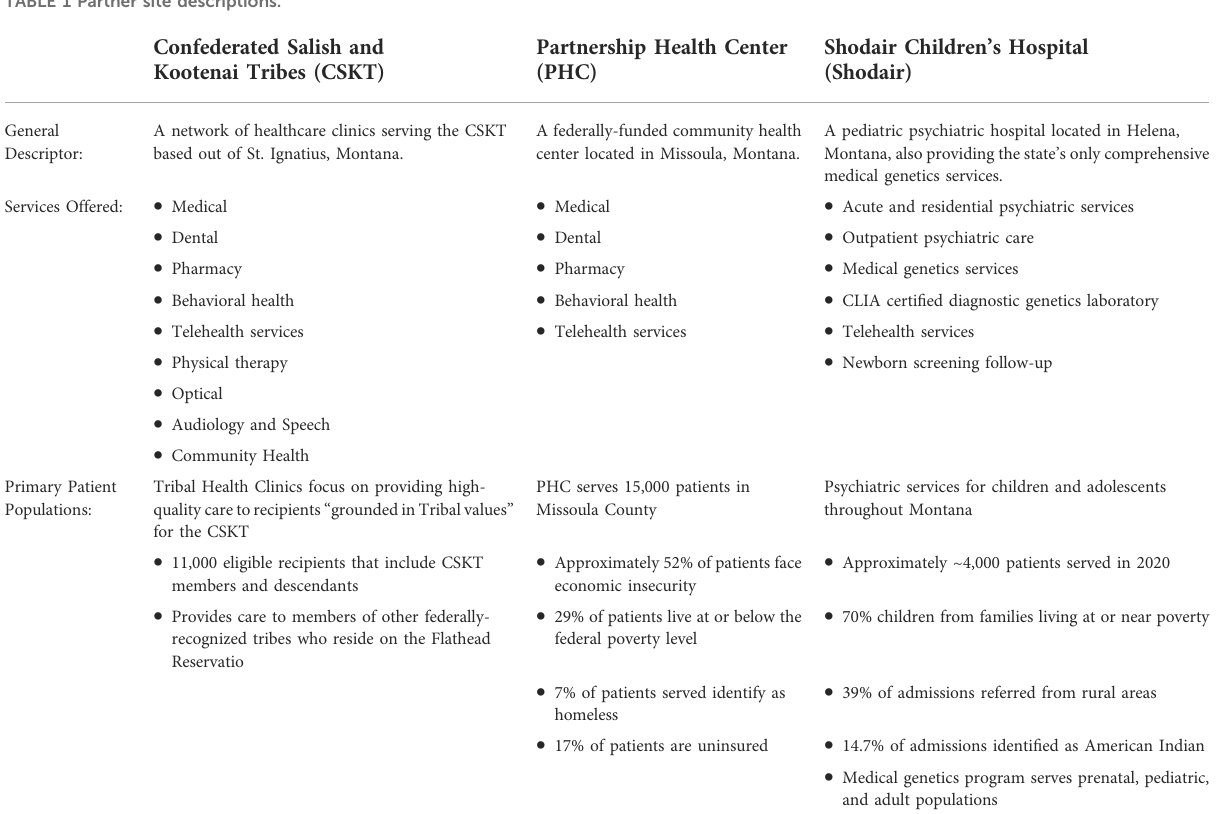
TABLE 1 Partner site